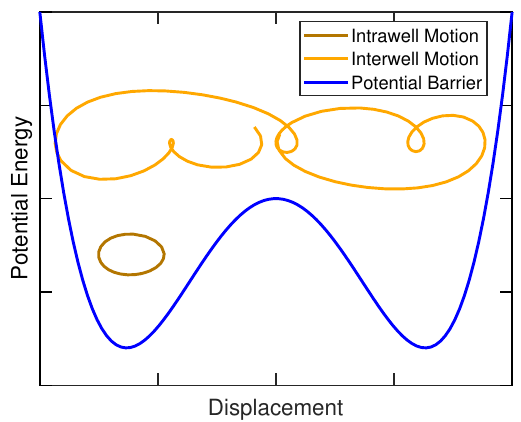
Fig. 2. An example bistable double well potential energy barrier and motion.